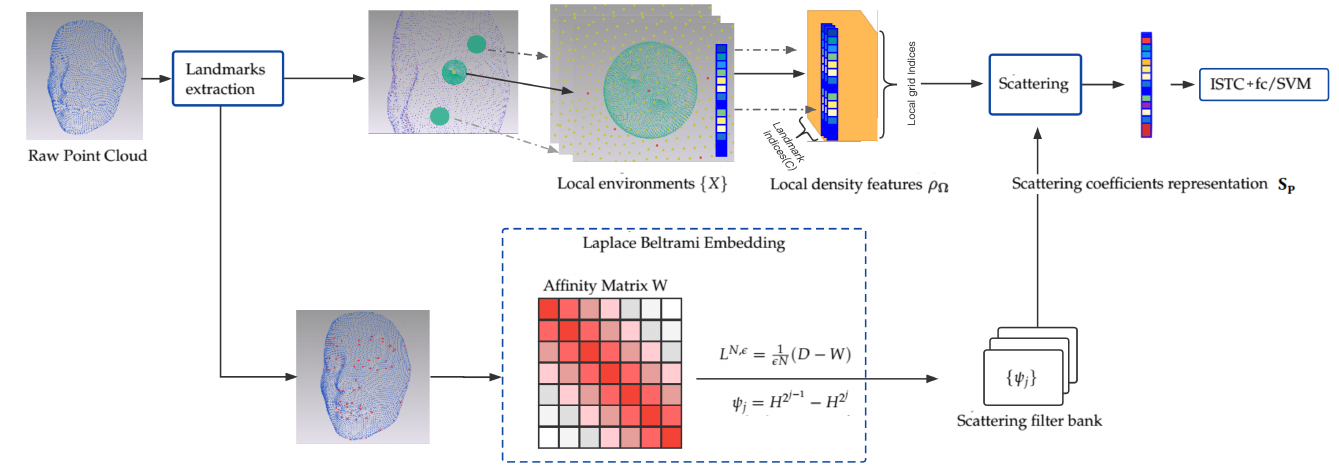
Figure 1. Overall framework for 3D